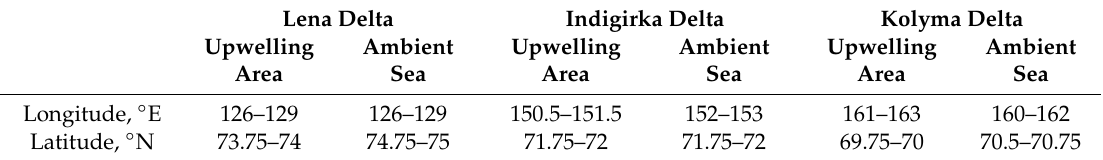
Table 1. Coordinates of reference areas used to identify upwelling events near the Lena, Indigirka, and Kolyma deltas. Lena Delta Indigirka Delta Kolyma